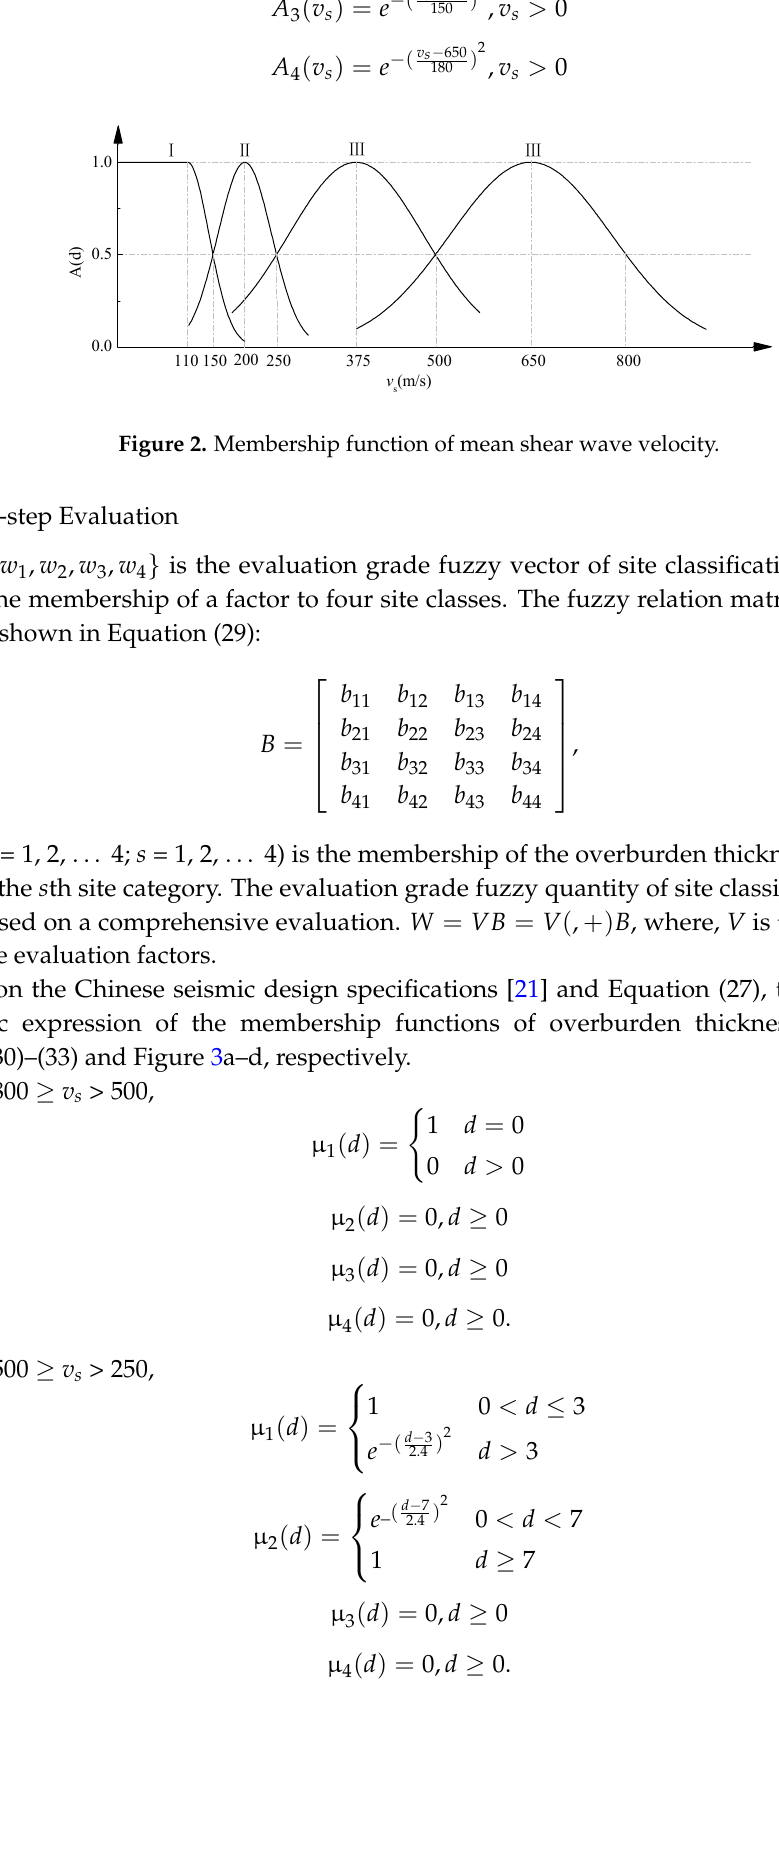
Figure 3. Membership function of thickness of covering layer. ( a ) 800 ≥ v s > 500; ( b ) 500 ≥ v s > 250; ( c ) 250 ≥ v s > 150; and ( d ) v s ≤ 150.